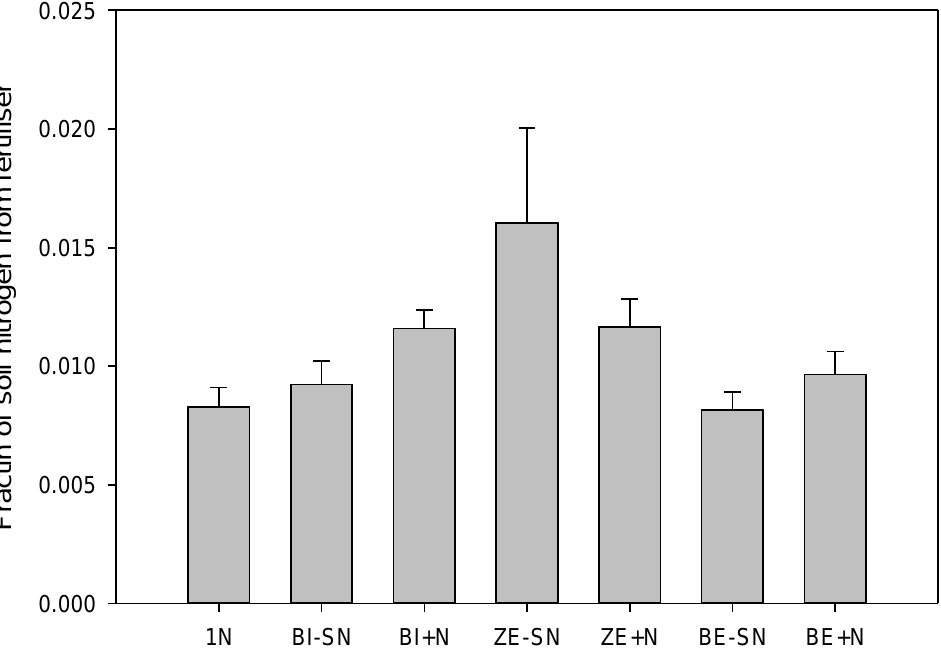
1N BI-SN BI+N ZE-SN ZE+N BE-SN BE+N Figure 3. Fraction of soil N from applied fertiliser after plant growth, calculated from 15N signature. Error bars are standard error (n = 3). 1N = full mineral N fertilizer, no sorbent, BI = biochar sorbent, ZE = zeolite sorbent, BE = bentonite sorbent. When sorbent and N fertilizer are both mixed into the soil separately, -SN is added. When N fertilizer is applied sorbed with the sorbent +N is added.